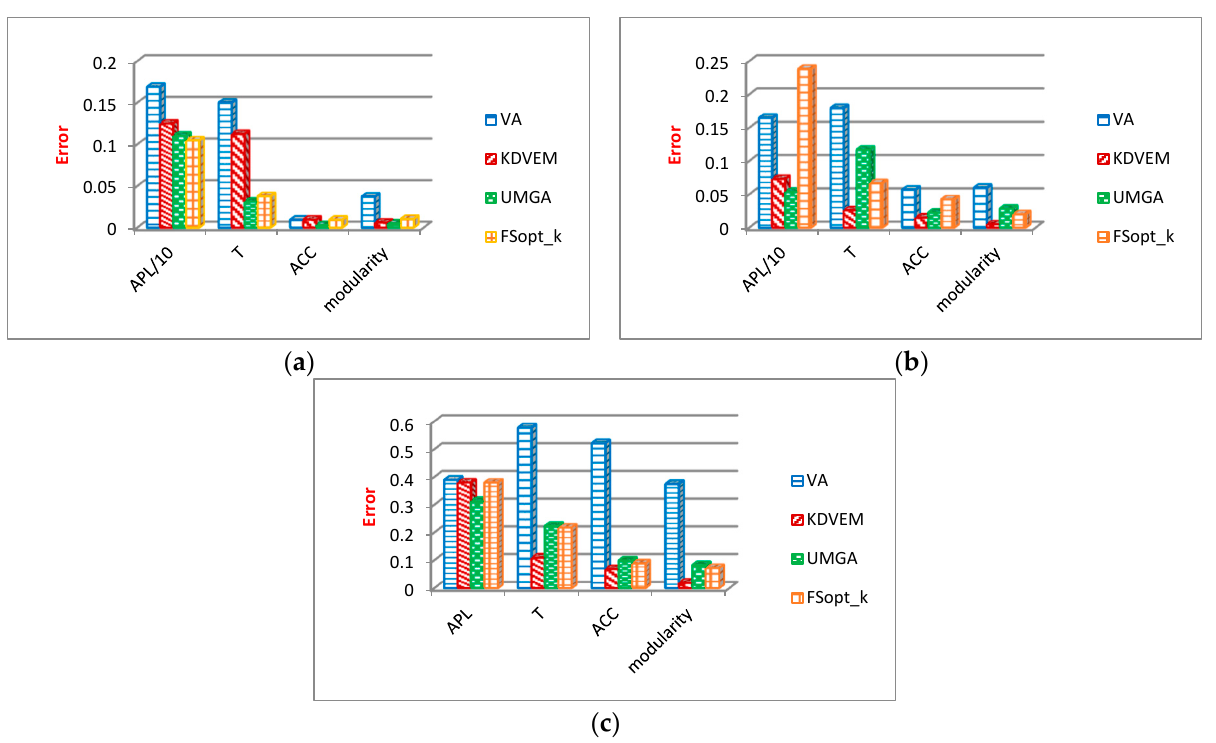
Figure 9. Comparison of error values of the algorithms on netscience dataset for (a): ℒ = 0.05 , (b): ℒ = 0.1 , and (c): ℒ = 0.2 .